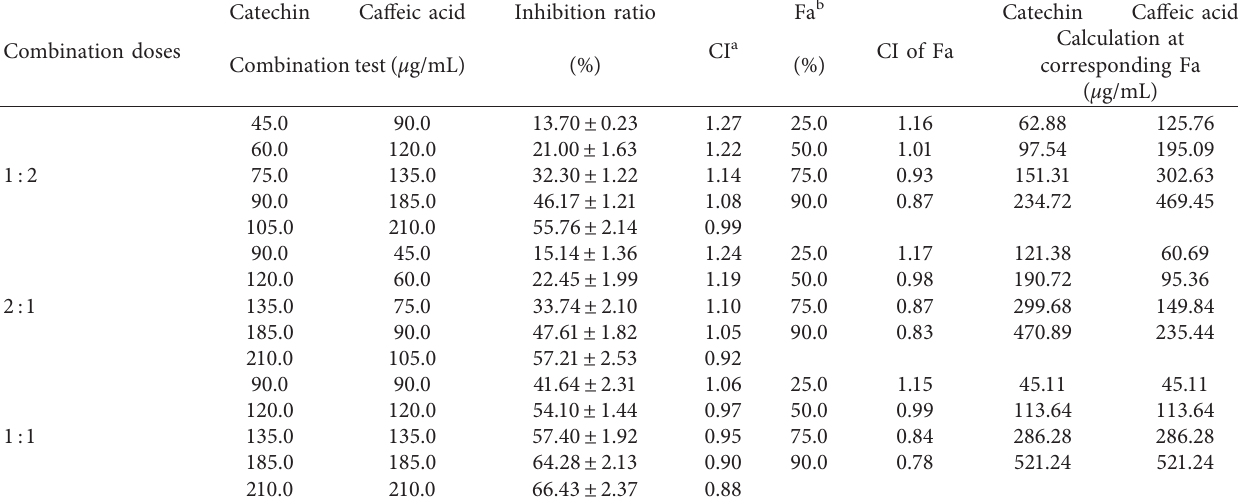
Table 1: The interactions between catechin and caffeic acid on inhibition of pancreatic lipase. Combination doses